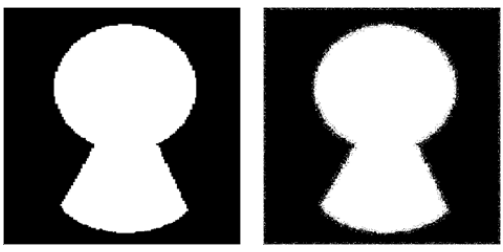
Figure 13. Binary image with simulated acquisition